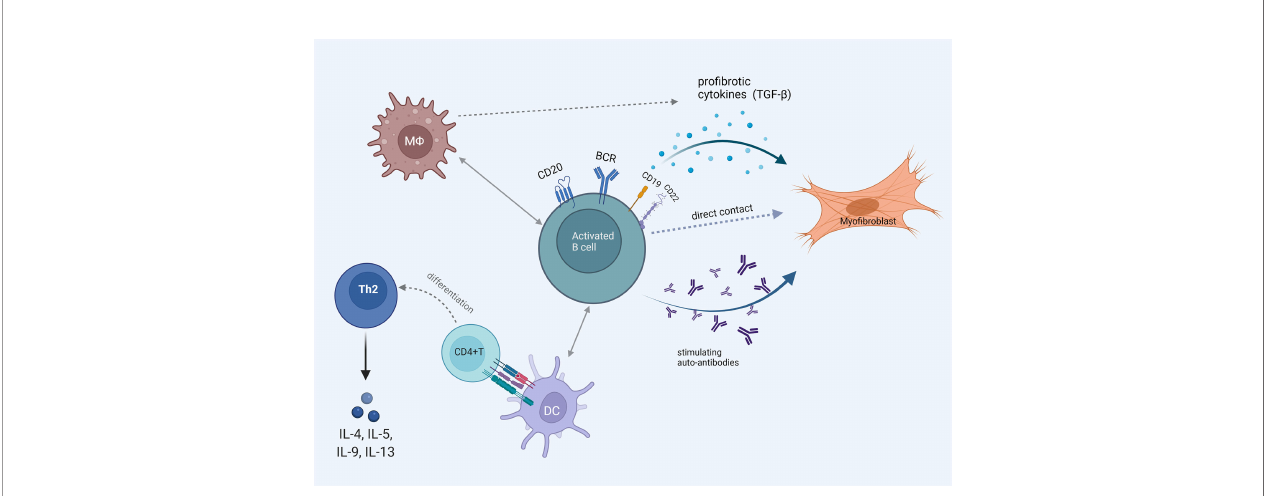
FIGURE 3 | The multiple faces of B cell activation that promotes fi brosis. Pathogenetically involved autoantibody production and B cell direct pro fi brotic cytokine release. Cell interaction with fi broblasts, macrophages and dendritic cells leading to Th2 mediated pro fi brotic cytokine release and myo fi broblast